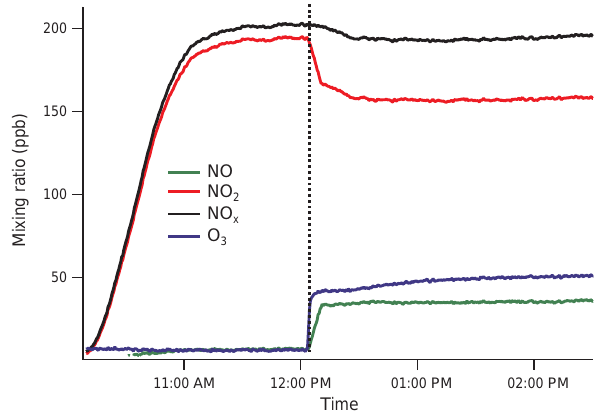
Figure A1. The temporal profiles of NO 2 , NO, NO x and O 3 at the end of the CPOT during a NO 2 photolysis experiment. The lamps were turned on at the time indicated by the dashed